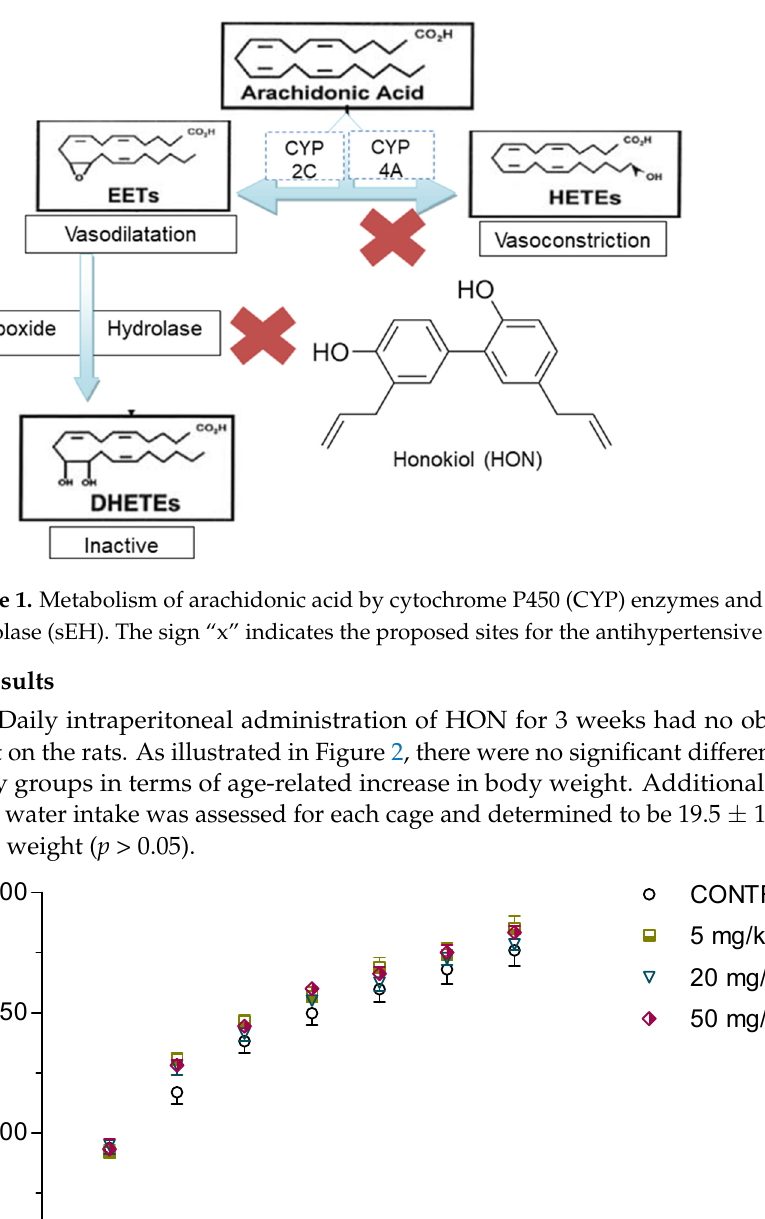
Figure 2. Average weekly body weight of control and HON-treated spontaneously hypertensive male rats. Data are presented as mean ± SEM, with each data point representing n = 8. No statistically significant differences were detected between control and treated rats.